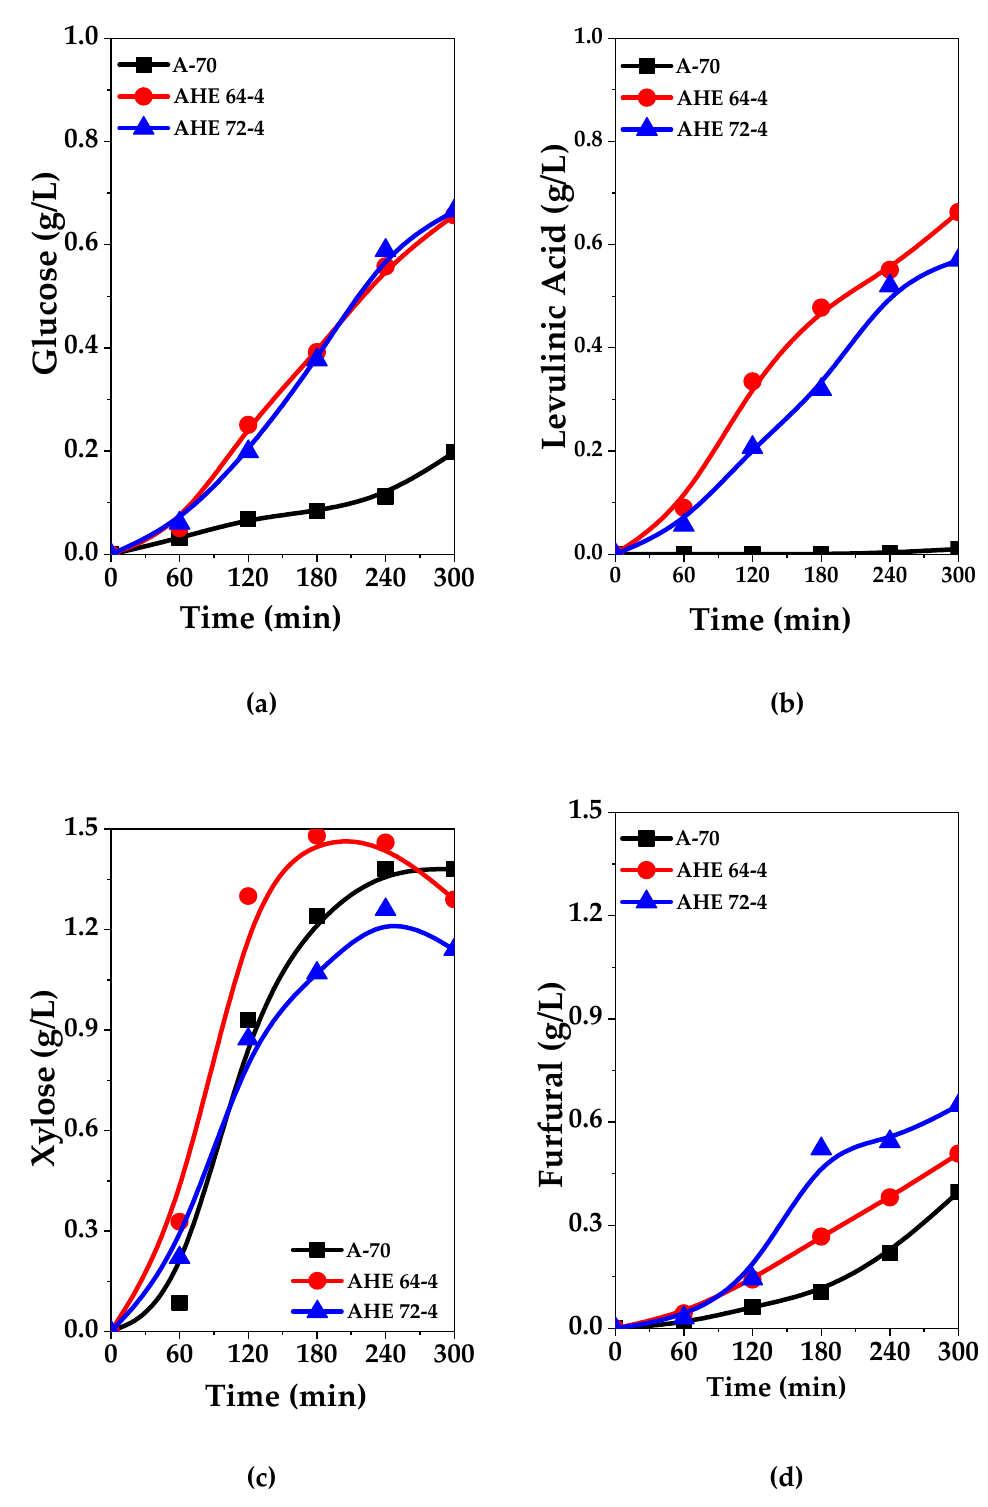
Figure 10. The concentration of ( a ) glucose, ( b ) levulinic acid, ( c ) xylose and ( d ) furfural over time in the hydrolysis of wheat straw catalyzed by the AHE materials at 140 °C.